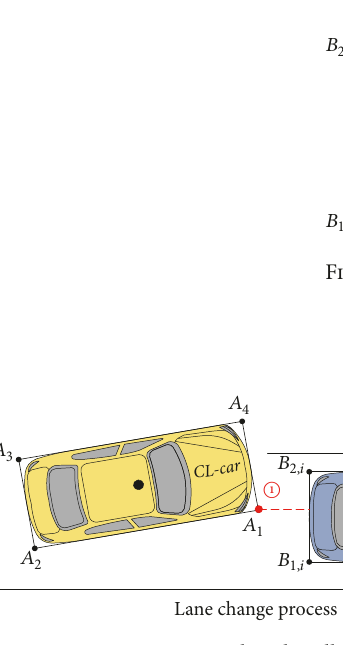
Figure 7: Potential angle collision point positions in different lane change processes between CL-car and P-front .